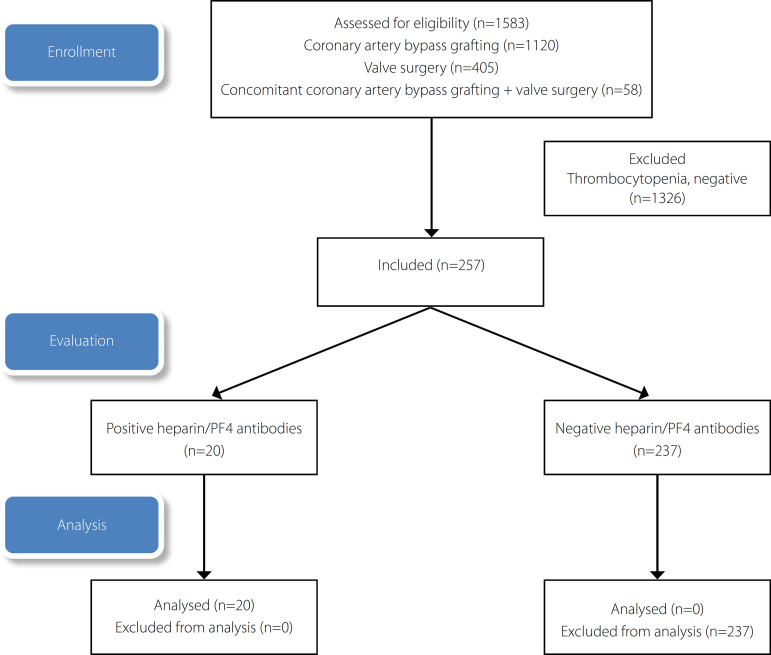
Flow diagram of the study. PF4=platelet factor 4.